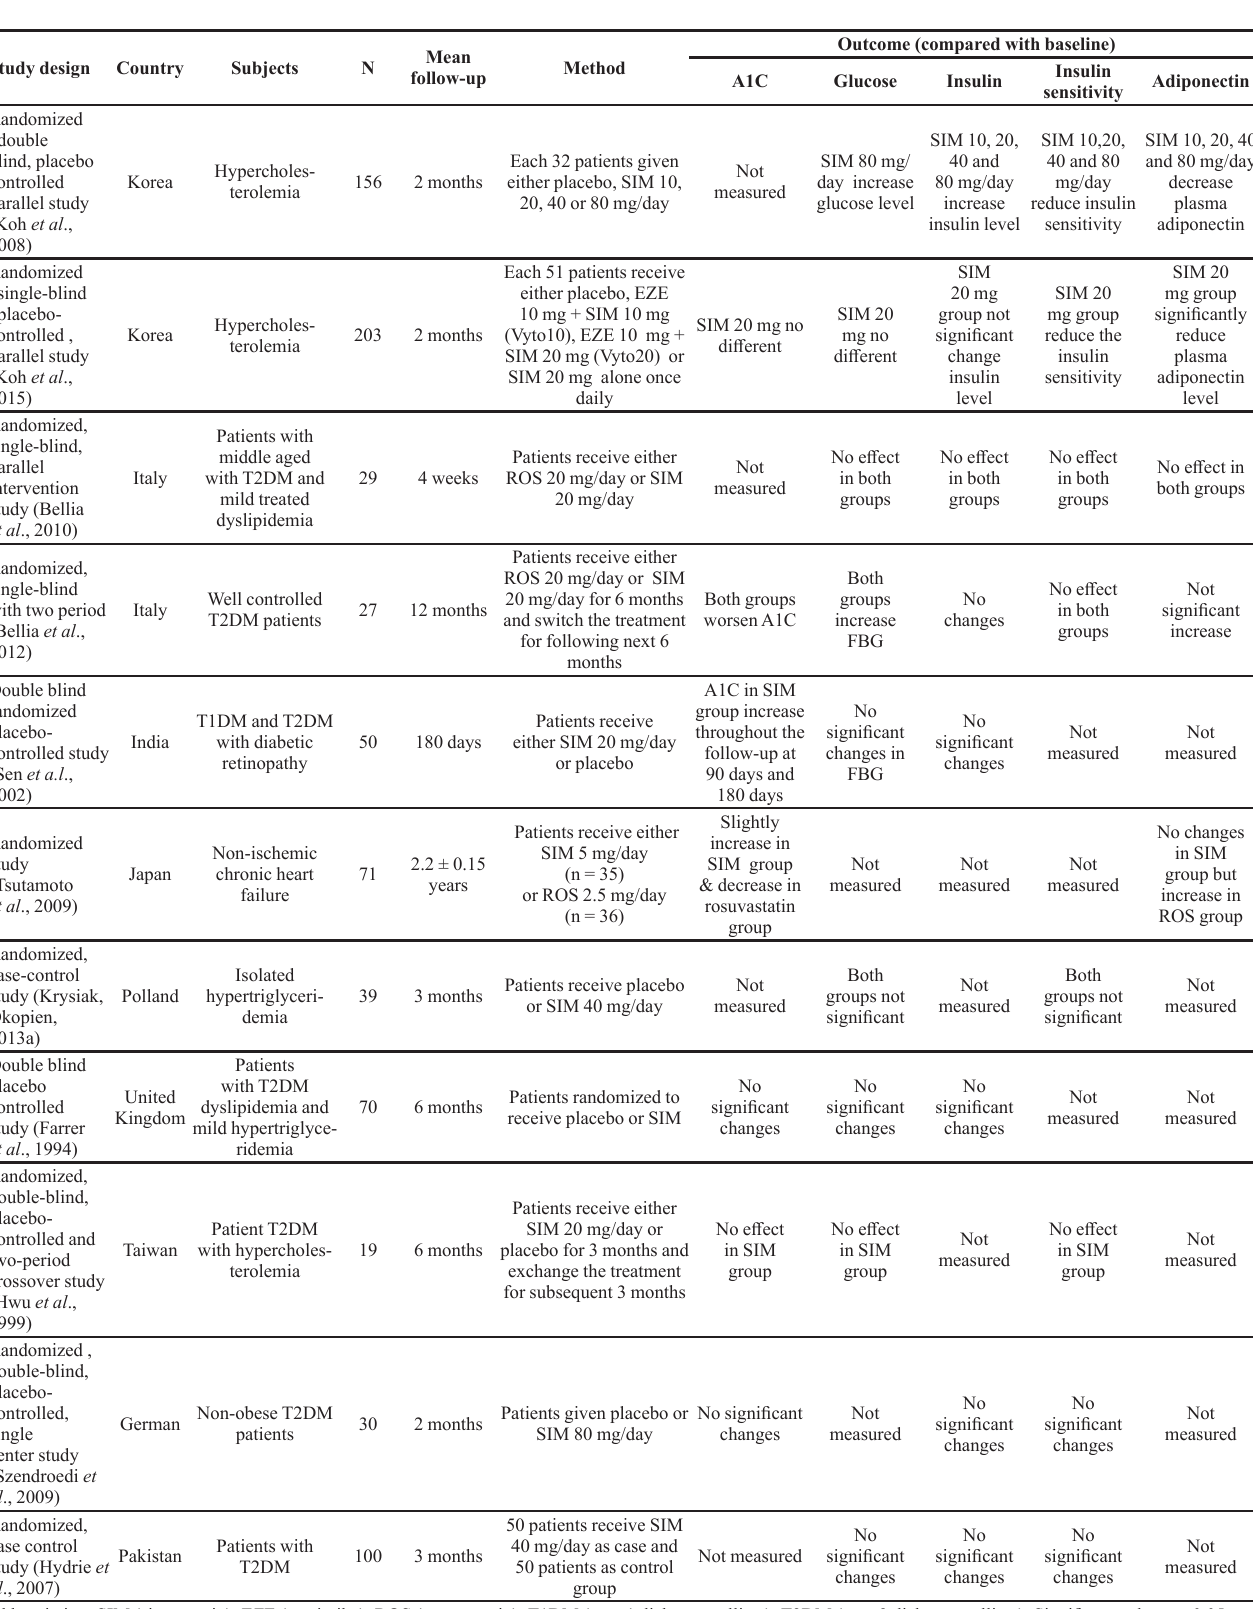
TABLE I - The effect of simvastatin on glucose metabolism markers in human data